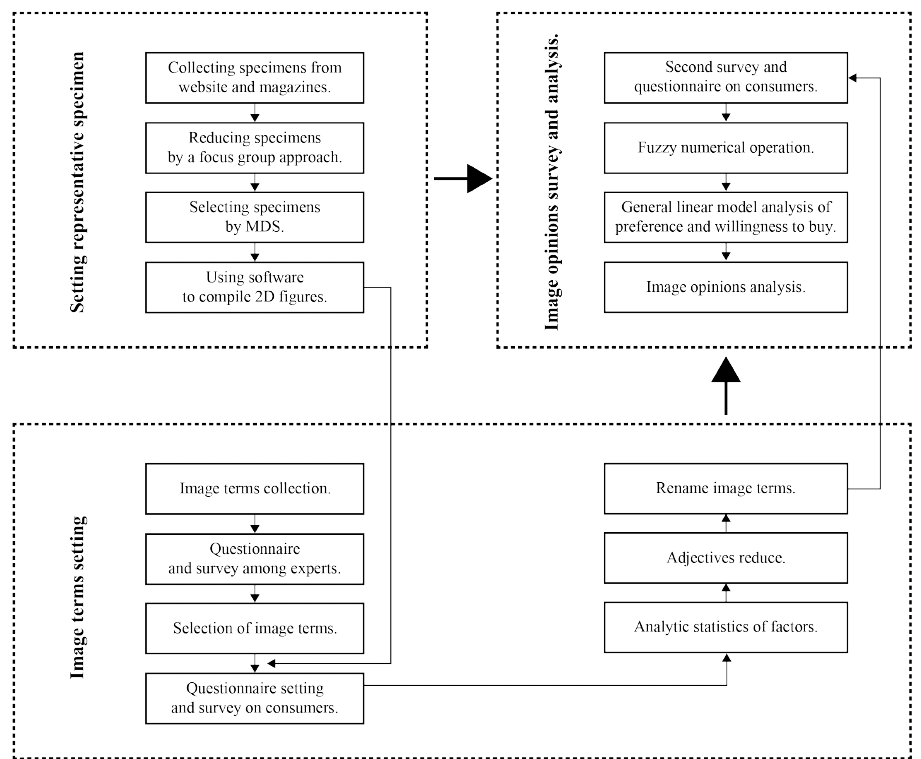
Figure 1. The research framework of this study.